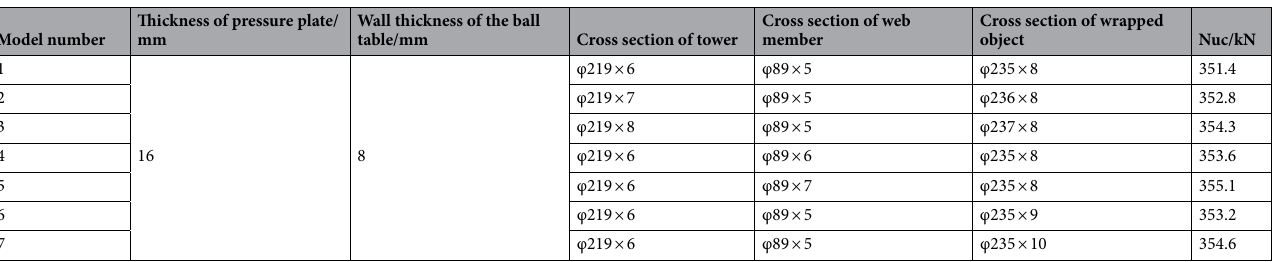
Table 9. Parameter